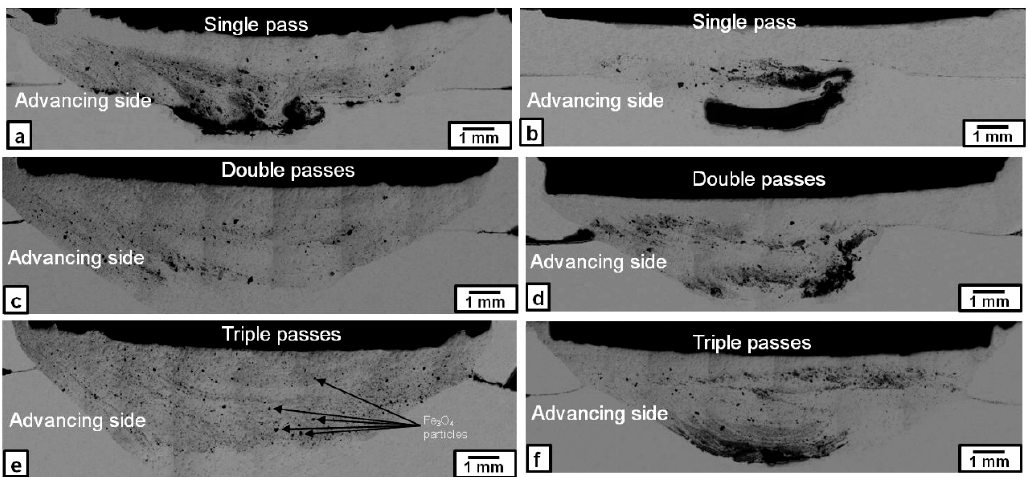
Figure 7. Macrographs of the Fe 3 O 4 particles distribution in the nugget zone produced by single,